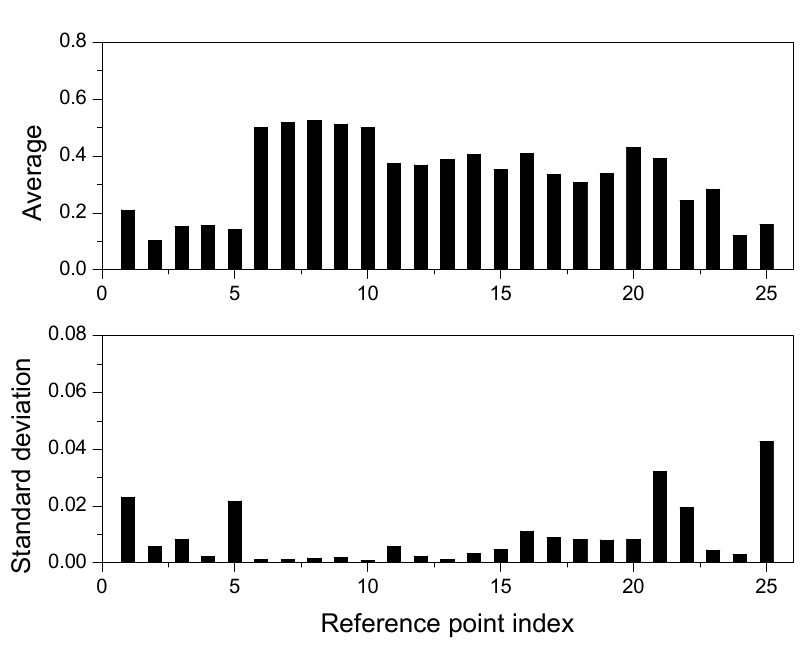
Figure 12. Calibration results.